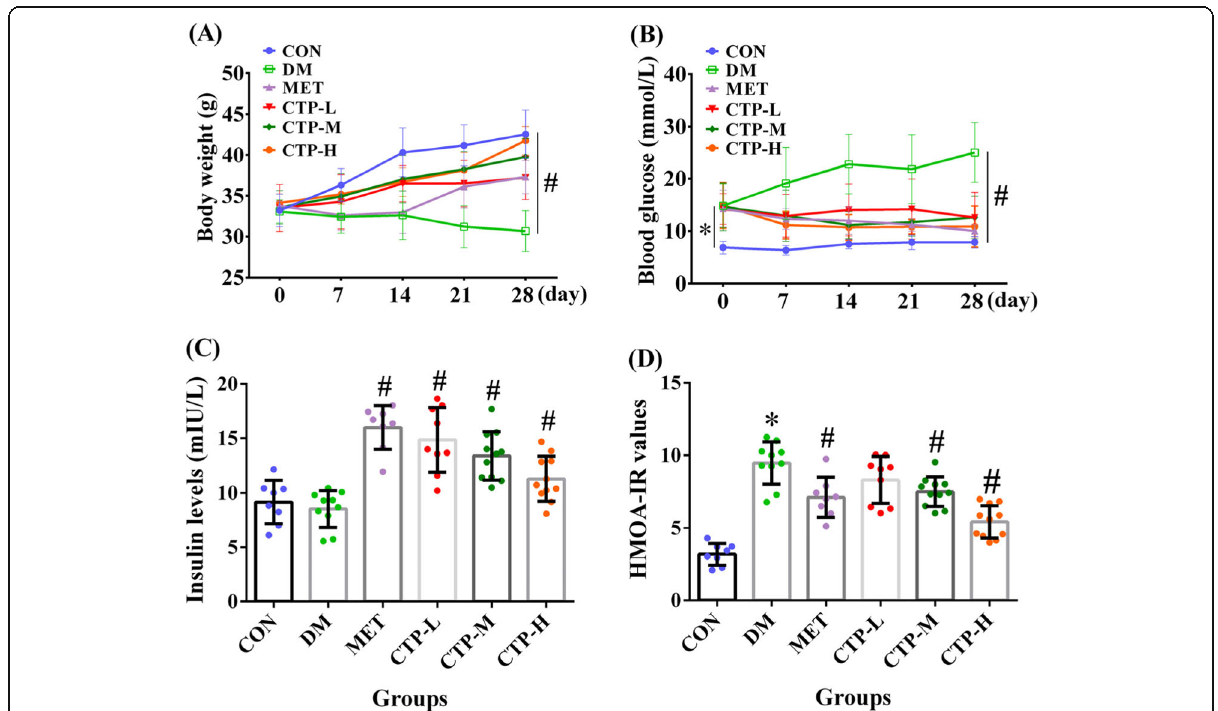
Fig. 2 Effects of CTP on body weight, FBG, insulin level, and HOMA-IR value in STZ-induced diabetic mice. a Body weight was measured at regular intervals after CTP treatment. b FBG level was measured at regular intervals after CTP treatment. c Insulin level was measured 28 days after CTP was administered. d HOMA-IR value was estimated 28 days after CTP was administered. Data are presented as mean ± SD ( n = 8 – 12). * p < 0.05 as compared with the normal control group (CON). # p < 0.05 as compared with